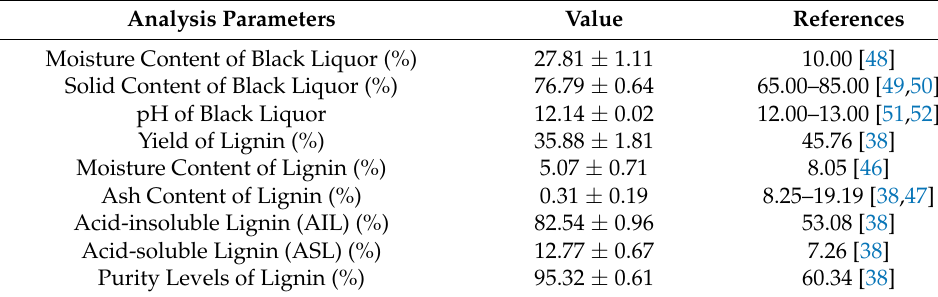
Table 1. Characteristics of lignin isolated from black liquor.